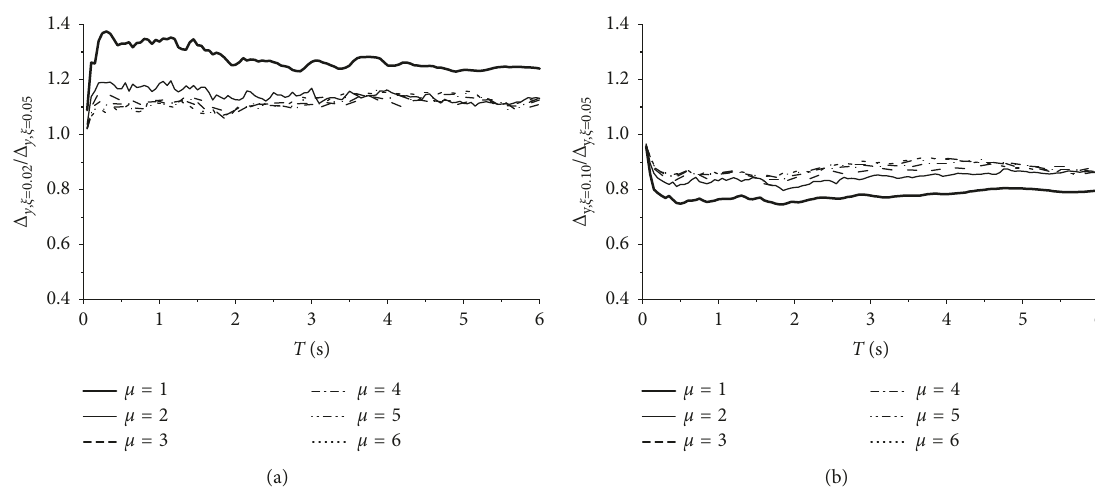
Figure 8: Normalized Δ y for two damping ratios and soil site B considering various combinations of T and μ : (a) ξ 0.000.050.100.150.20 C y